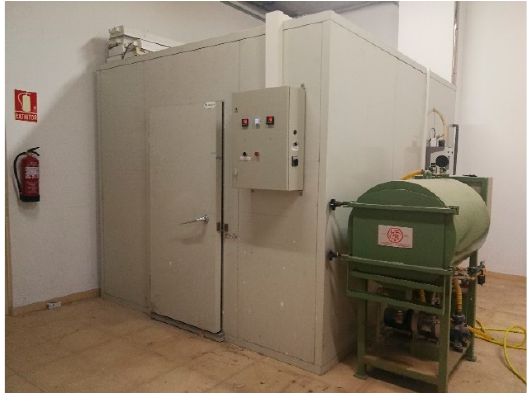
Figure 4. Temperature and humidity-controlled chamber at the School of Forestry, Agronomic and Bioenergy Industry Engineering (EIFAB) in Soria, Spain.